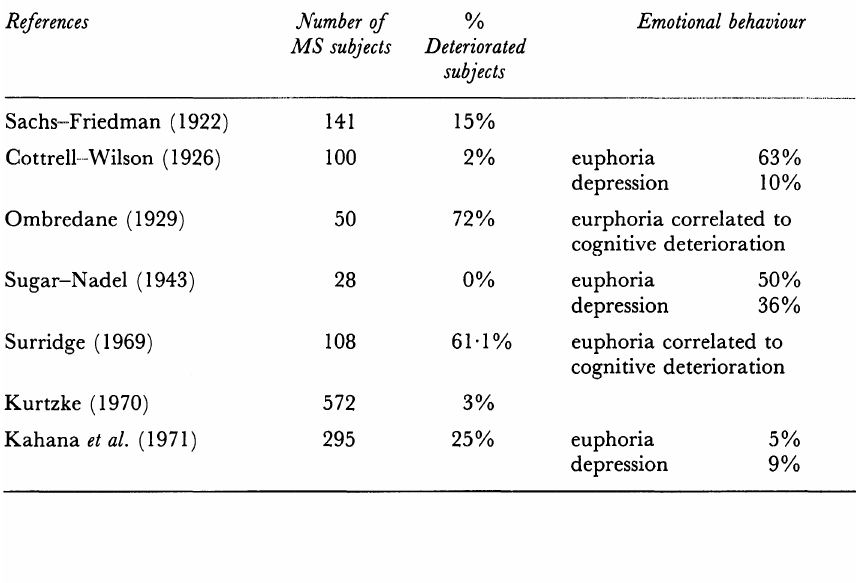
of cognitive impairment in M S derived from various neuropsychological TABLE 2. Prevalence